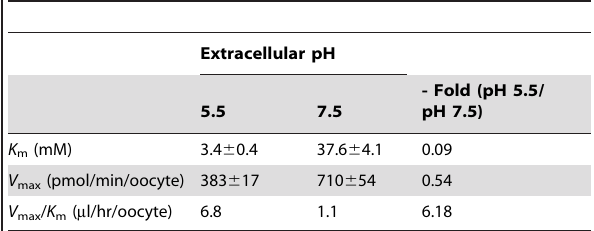
Table 1. Effect of extracellular pH on kinetic parameters of L- lactate uptake by hMCT4-expressing oocytes.